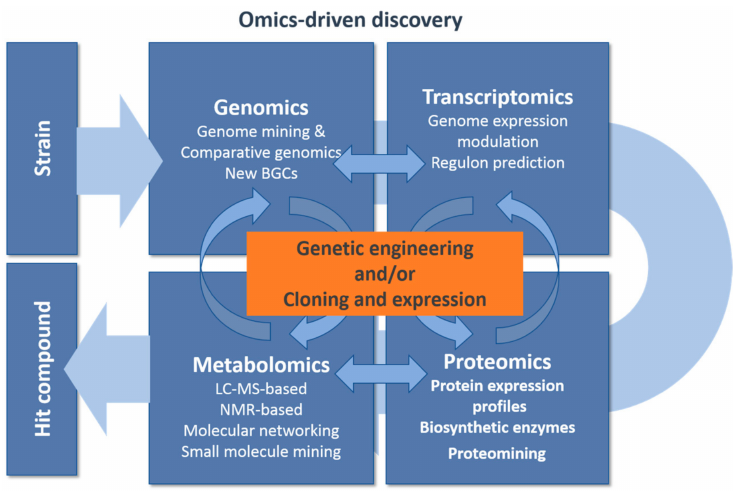
Figure 2. Omics-driven